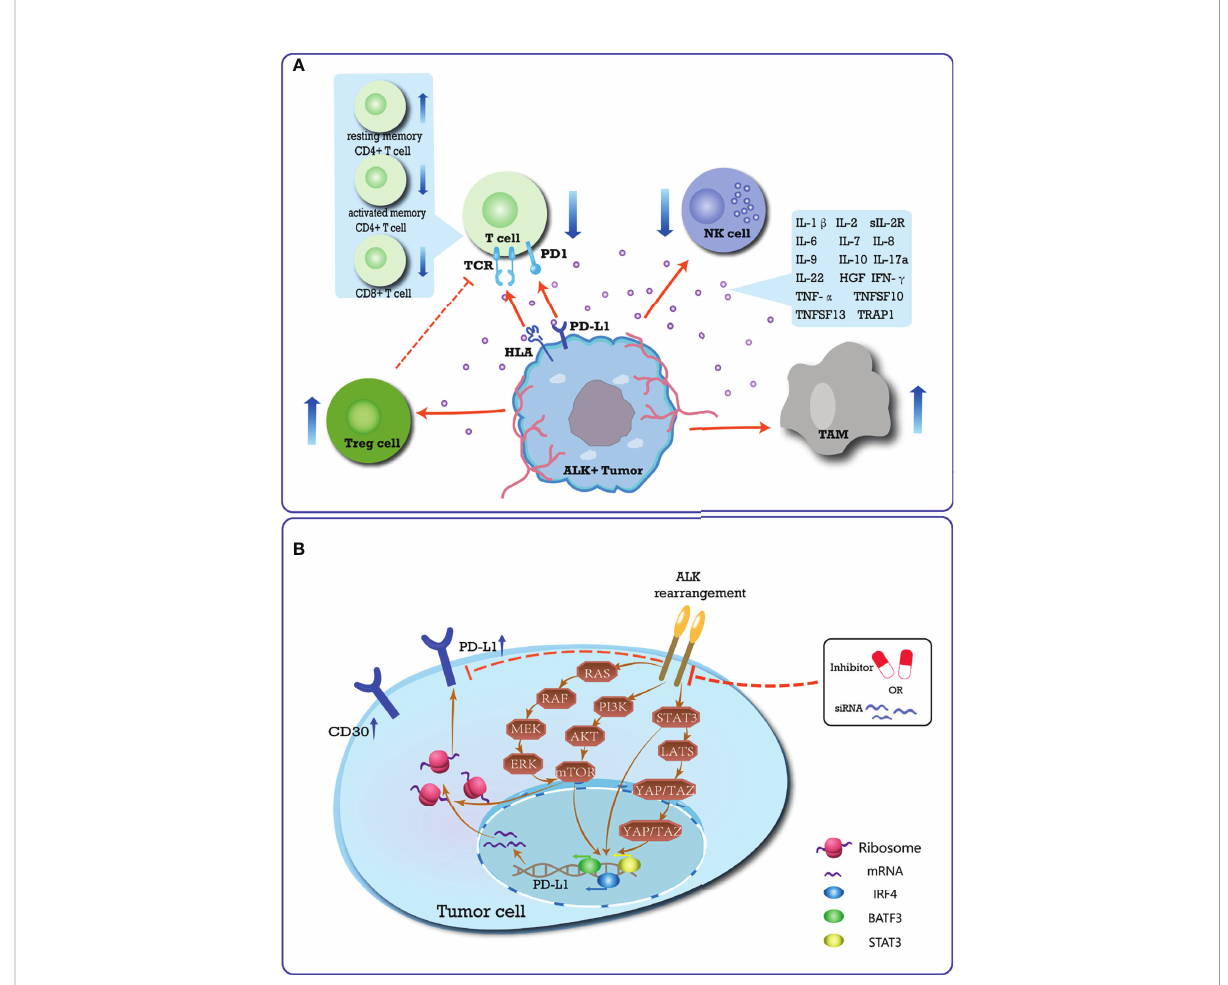
FIGURE 1 Summary of the immune-suppressive microenvironment induced by ALK-rearrangement. (A) Schematic diagram of the special immune TME of ALK-positive tumor. In ALK-positive tumors, CD30 is expressed continuously, and TCR signaling is inhibited. In the TME, the types of T cells changed, that is, the number of resting memory CD4+ T cells increased, while CD8+ T cells and activated memory CD4+ T cells were lacking. A variety of immunosuppressive cytokines are up-regulated, thereby inhibiting the killing ability of T cells and NK cells to tumor cells, and promoting the function of immunosuppressive cells. The special TME accumulates more Treg cells and TAM cells to promote immune evasion; (B) Mechanism of ALK rearrangement upregulating PD-L1 expression, which plays an essential role in mediating the process of PD-L1 expression. ALK-rearranged protein can activate STAT3, PI3K-AKT-mTOR, and MEK-ERK signaling networks, which upregulate PD-L1 expression through transcription factors acting on the promoter region of PD-L1 gene. Activated mTOR can also recruit PD-L1 transcripts to active polysomes at the post-transcriptional level. The JAK-STAT3-LATS-YAP/TAZ-PD-L1 signaling pathway has gradually been shown to play an important role in mediating ALK-induced upregulation of PD-L1 in multiple cancer cell lines. Conversely, blocking the activation of the ALK pathway inhibits the expression of